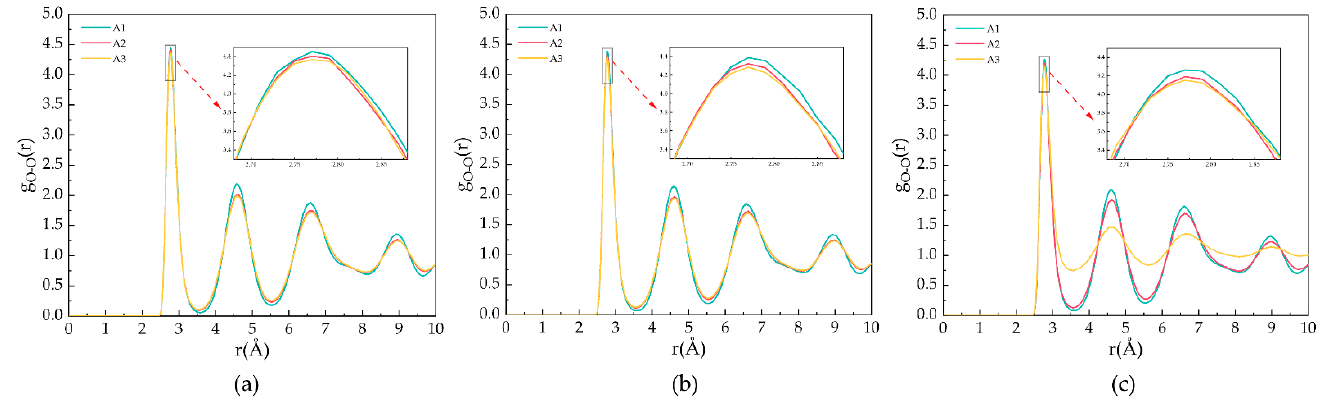
Figure 3. RDFs of oxygen atoms in H 2 O molecules of A1, A2, and A3 model after 500 ps at P = 2 MPa and three different temperatures for ( a ) T = 273 K, ( b ) T = 283 K, and ( c ) T = 293 K.